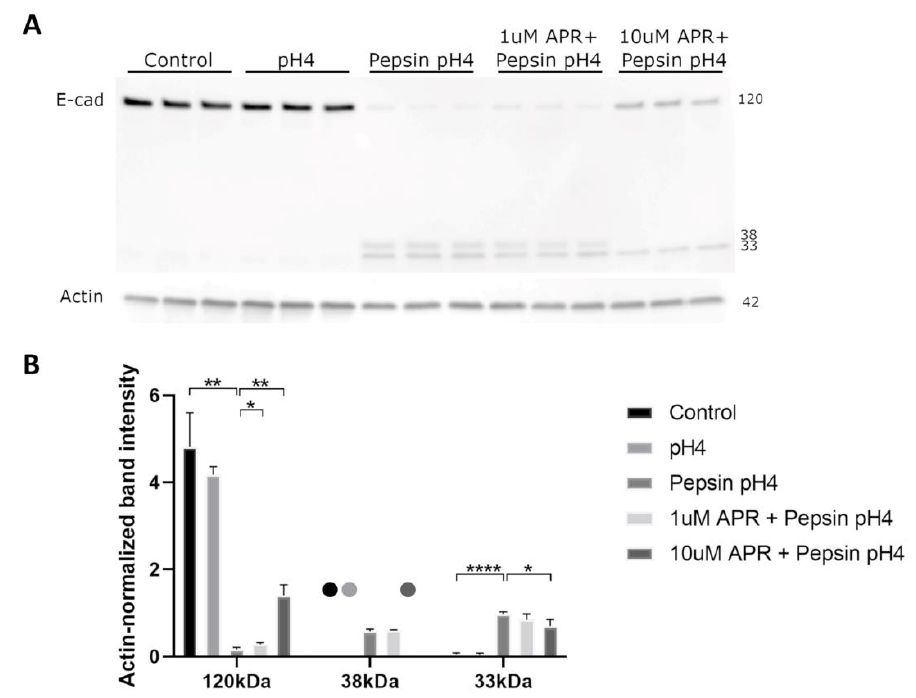
Figure 2. Western blot ( A ) analyzed by densitometry ( B ) showed that acidified pepsin elicited E- cadherin cleavage via regulated intramembrane proteolysis (RIP), producing C-terminal